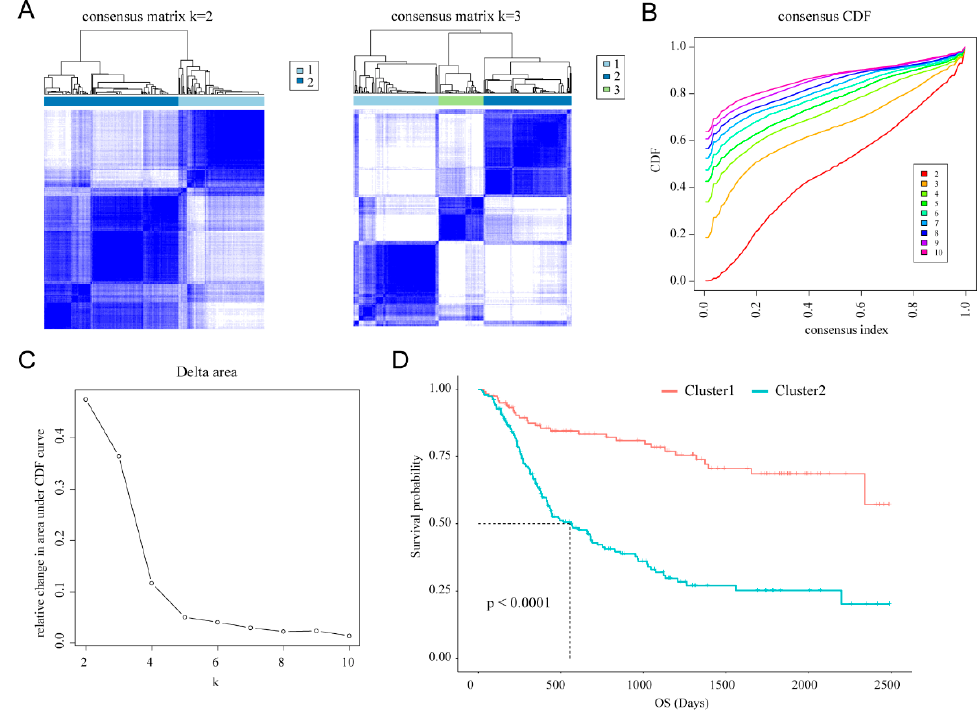
Figure 1. Classification of gliomas based on the cellular response to IL-4-related gene set in CGGA dataset. ( A ) Consensus clustering matrix of 325 CGGA samples for k = 2 and k = 3. ( B ) Consensus clustering CDF for k = 2 to k = 10. ( C ) Relative change in area under CDF curve for k = 2 to k = 10. ( D ) Survival analysis using Kaplan–Meier method for two clusters.